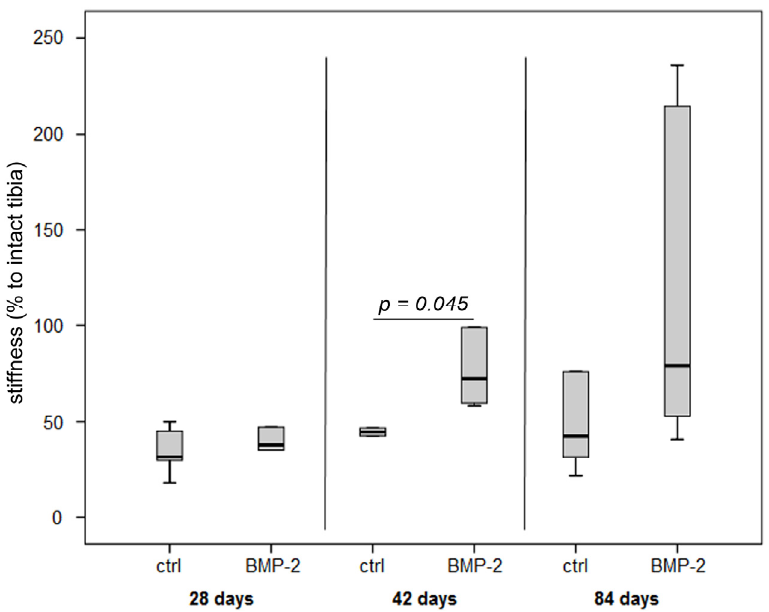
Figure 5. Results of the biomechanical testing of osteotomized tibiae expressed as normalized stiffness to the respective intact